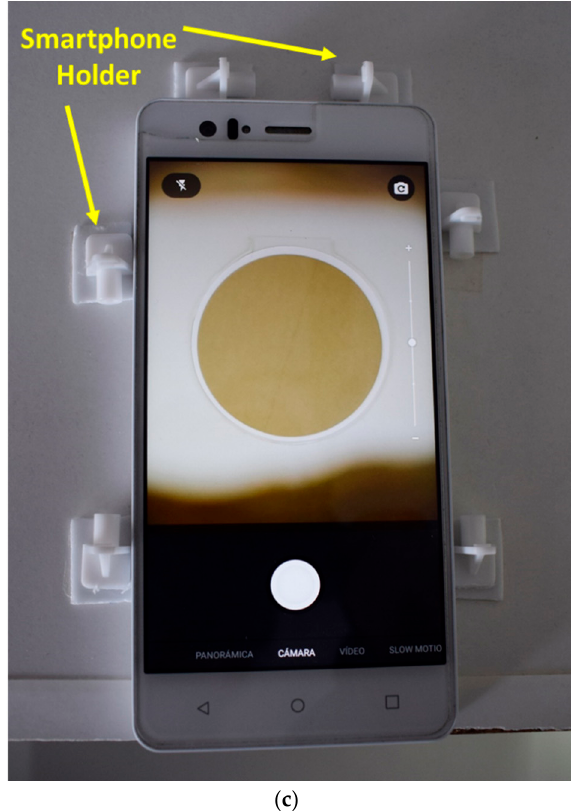
Figure 2. ( a ) Home-made low-cost photographic system for monitoring PM samples; ( b ) view of the sample holder and LED strip light source; ( c ) a PM sample image obtain with the system.